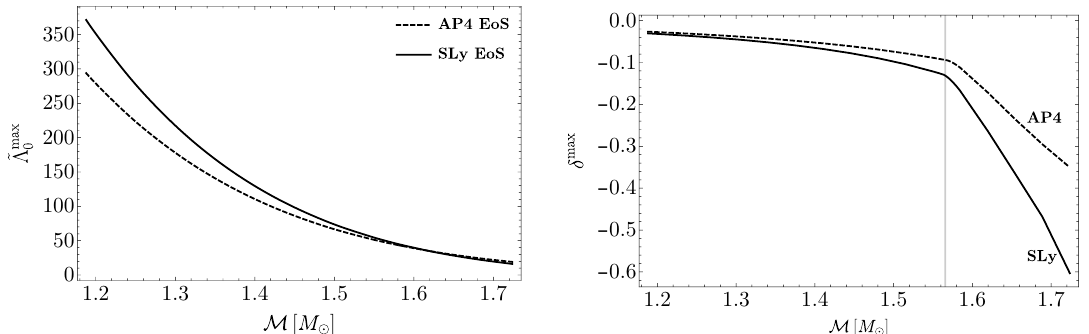
Figure 9. Dependence on the chirp mass in the AP4 and SLy parametrizations, keeping the heaviest star mass (cid:12)xed at M 1 = 1 : 98 M (cid:12) (the maximum value for the (cid:3) = (120 MeV) 4 curve). The chirp mass range is from M = 1 : 188 M (cid:12) to M (cid:25) 1 : 72 M (cid:12) , where the latter corresponds to the case when both stars have masses M 1 ; 2 = 1 : 98 M (cid:12) . The left plot shows the corresponding value of the combined tidal deformability for the (cid:3) = 0 curves. The right plot represents the relative deviation of the combined tidal deformability and is a measure of how the e(cid:11)ect of VE potentially increases with the chirp mass. The vertical gray line denotes the chirp mass at which the light star mass reaches the critical mass for the phase